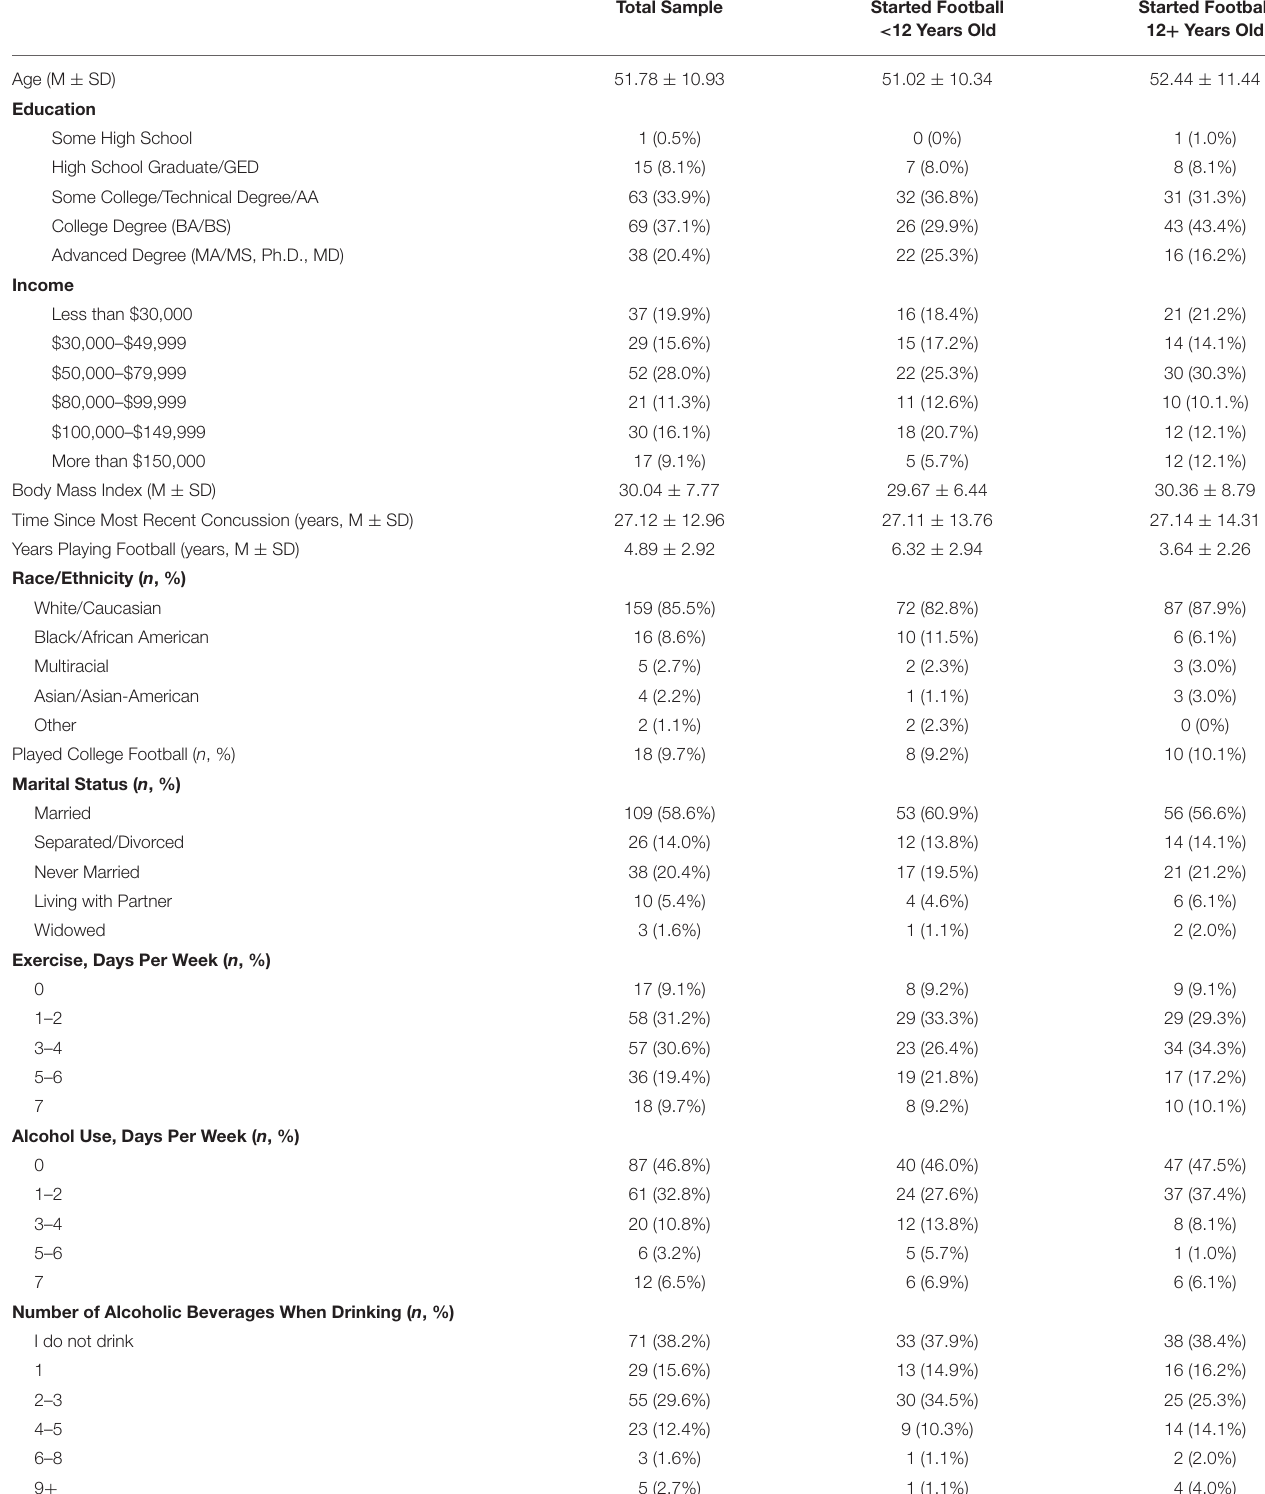
TABLE 1 | Demographic and Health